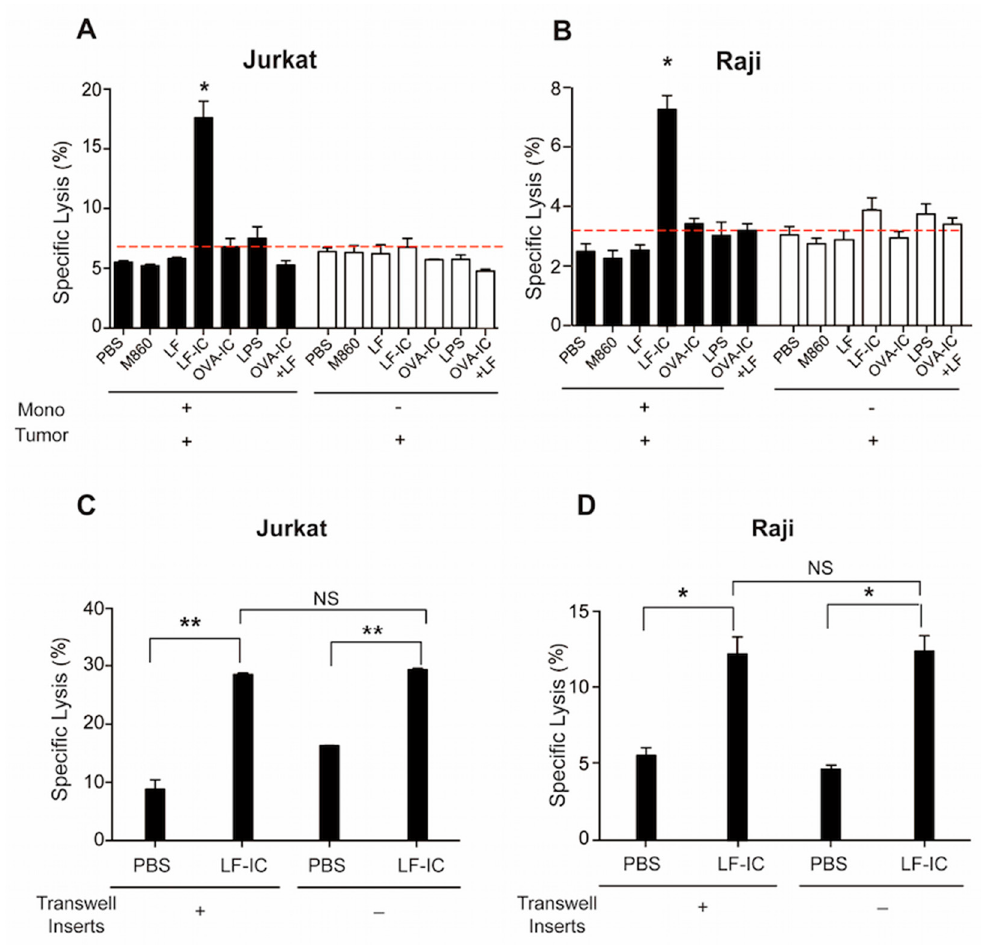
Figure 1. Human monocytes acquire tumoricidal activity after LF-IC stimulation. ( A , B ) Freshly purified human monocytes were primed with 30 µ g / mL LF, M860, LF-IC (M860 + LF), OVA-IC (OVA + M562), OVA-IC + LF or 10 ng / mL LPS for 24 h. CFSE labeled Jurkat ( A ) or Raji ( B ) were then added and incubated for 18 h, with Jurkat or Raji cells treated with LF, M860, LF-IC, OVA-IC as negative controls. ( C , D ) Freshly purified human monocytes were primed with 30 µ g / mL LF-IC. CFSE labeled Jurkat or Raji cells were seeded directly to the culture or were placed in transwell inserts. Cells were acquired and analyzed by Flow Cytometry with Propidium Iodide staining post co-culture for 18 h. Specific Lysis were expressed by the percentage of CFSE + PI + cell counts in CFSE + cell counts. * p < 0.05, ** p < 0.01.